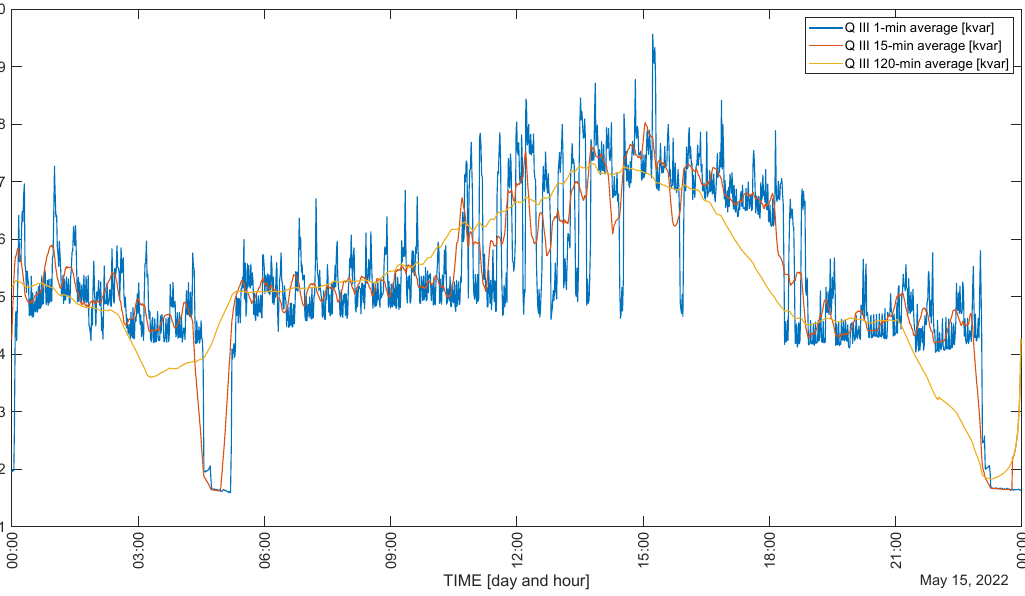
Figure 14. Three-phase reactive power as a function of time on a representative day of the 3rd stage. Table 4. Electricity consumption in successive stages of the cycle.